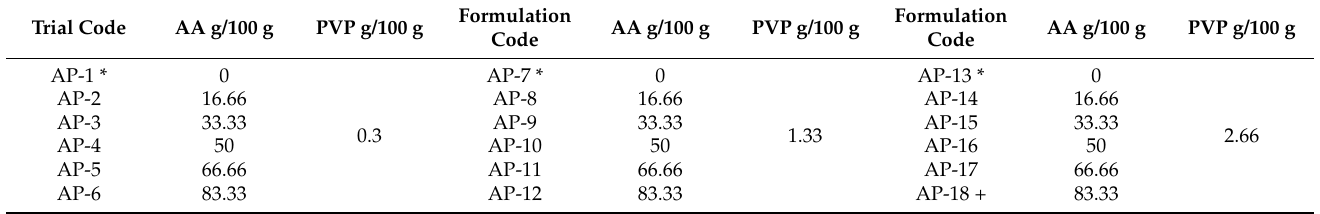
Table 1. Ingredients of HP- β -CD-g-poly(AA)/PVP semi-IPN hydrogel